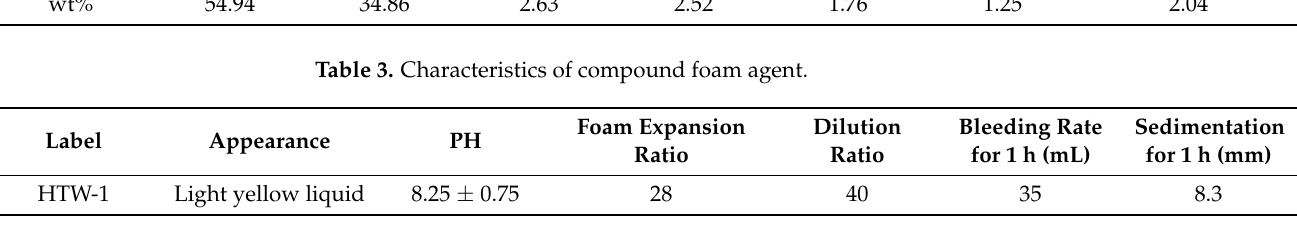
Table 4. Basic properties of PVA fiber.